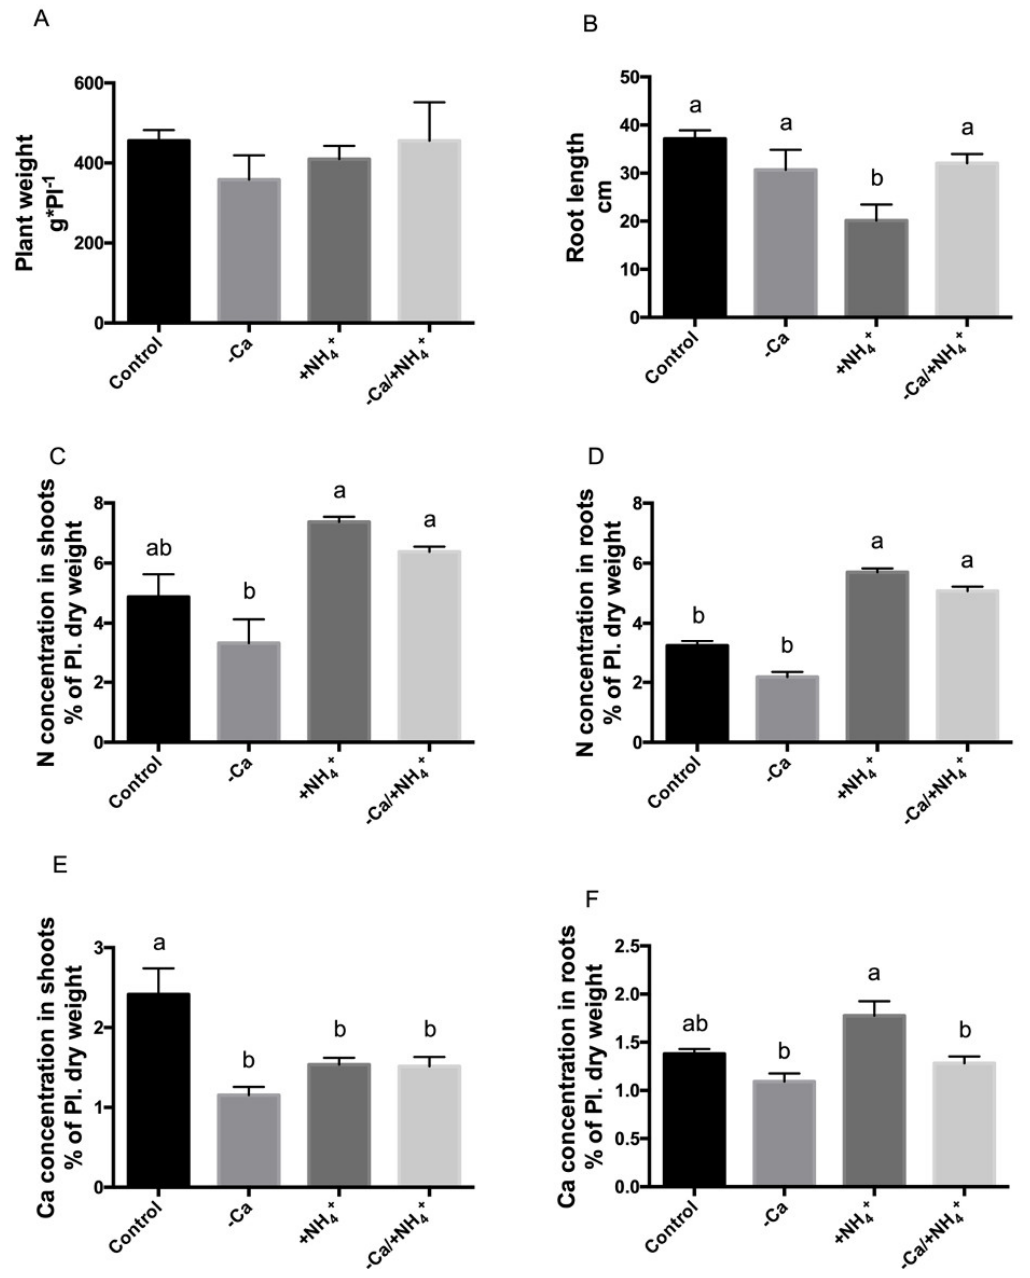
Figure 4. Tomato plants were affected by reduced calcium and/or ammonium excess in in-pot experiments. Tomato plants were watered with a fertilization solution containing all essential nutrients (control) or a fertilization solution with calcium deficit (-Ca), with ammonium excess (+NH 4 ), or both combined ( − Ca/+NH 4 ). At 132 days from seed, the plants were dissected, and the total plant weight ( A ) and root length ( B ) were analyzed. Total nitrogen ( C , D ) and total calcium ( E , F ) were determined as a percentage of plant dry weight, for shoot ( C , E ) and root ( D , F ) tissue. a, b represents statistically significant differences with p < 0.05.